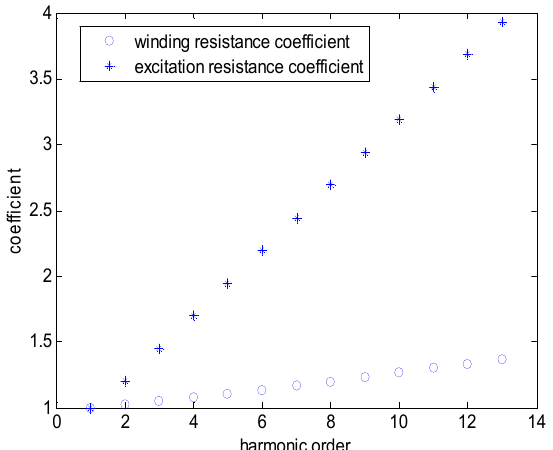
Figure 7. Change of coefficient with